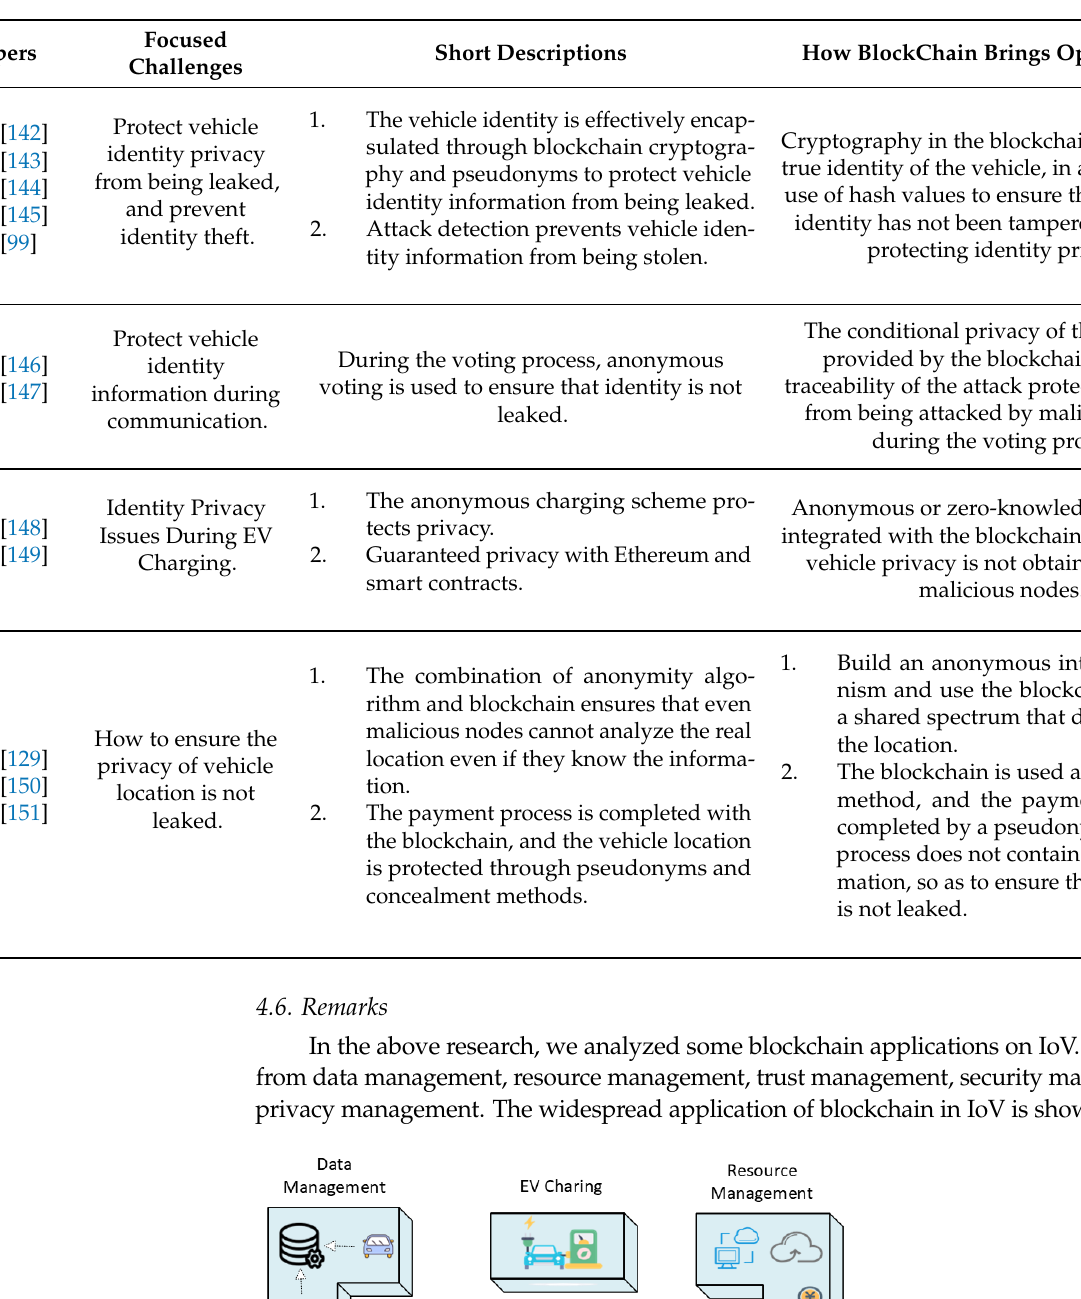
Table 8. Privacy Management Related Papers.